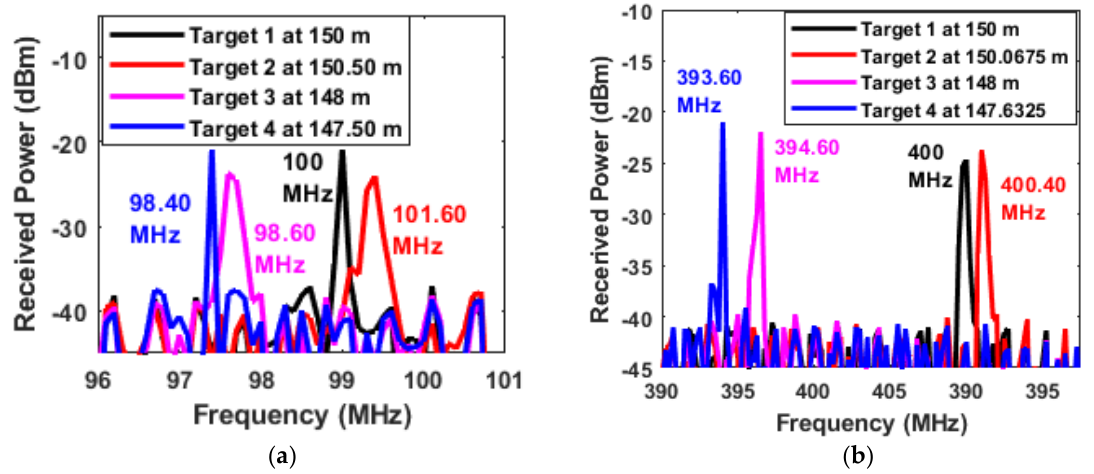
Figure 8. Power spectrum of de-chirped signal ( a ) separated by 50 cm at 1 GHz and ( b ) separated by 6.75 cm at 4 GHz.